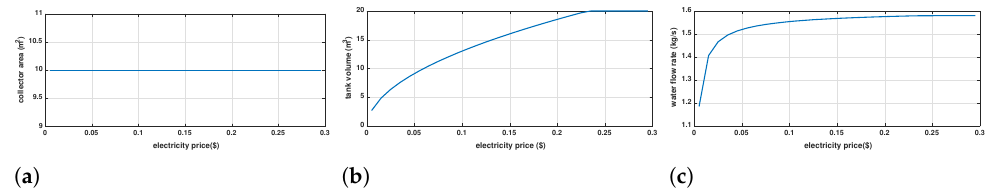
Figure 7. ( a ) Solar collector area versus electricity price, ( b ) storage tank volume versus electricity price, ( c ) hot water mass flow rate versus electricity price.